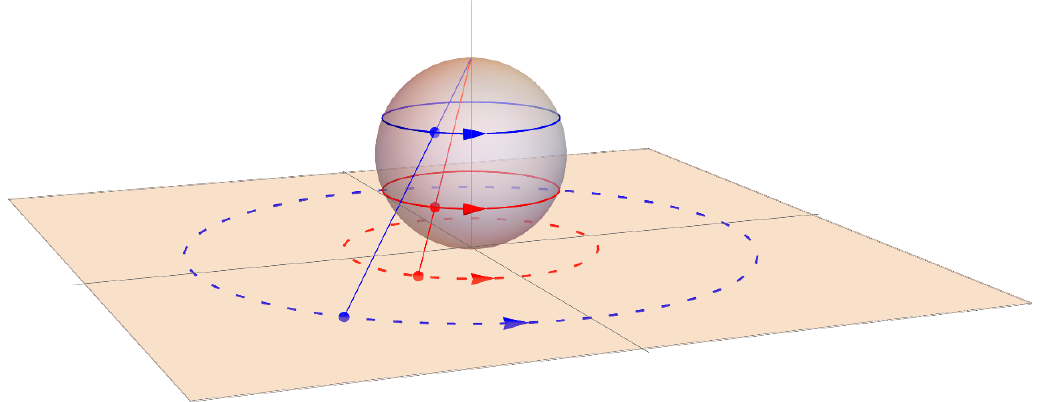
Figure 1 . A vortex-antivortex pair moving on the sphere at (cid:12)xed distance; in the stereographic projection the motion corresponds to two circular